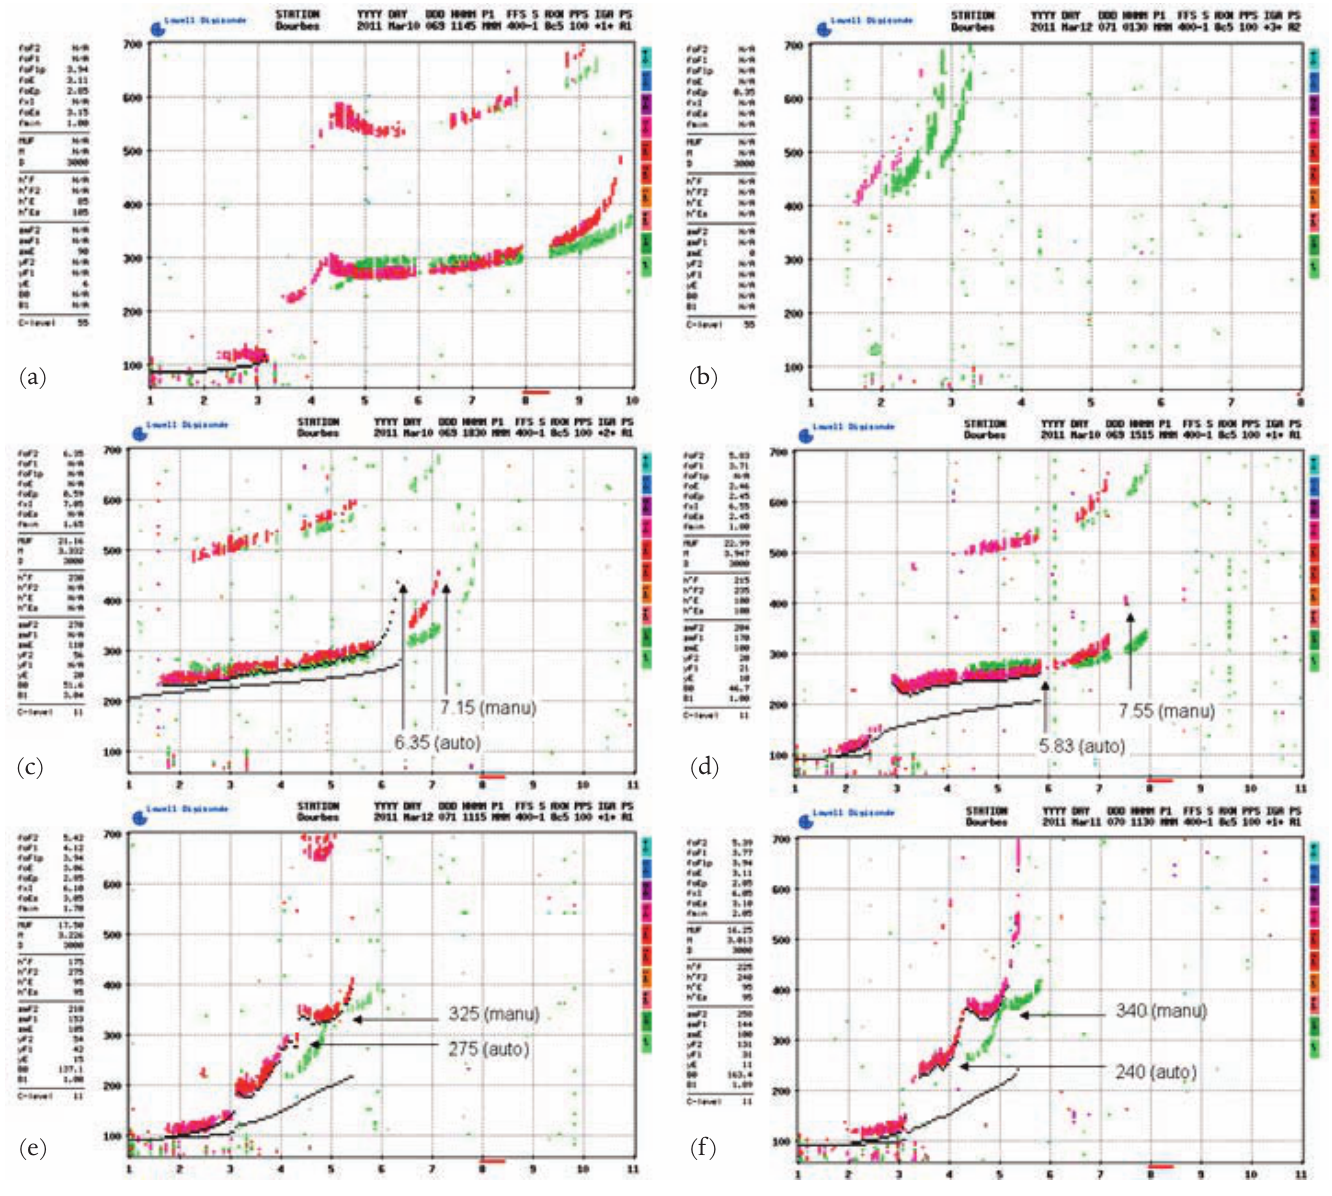
Figure 2. Autoscaled ionograms from Dourbes. (a, b) Autoscaling failures, as (a) partial, with only the E-layer parameters scaled, and (b) completely unscaled, as an example of the severely depleted ionosphere during a geomagnetic storm. (c, d) Gap occurrence (due to interference), where smaller gaps are successfully ignored/ interpolated, and larger gaps are falsely interpolated/extrapolated, resulting in the automatic layer trace being truncated prematurely (d). (e, f) Incorrect autoscaling of the h’F2 virtual height. Auto, automatic scaling; manu, manual